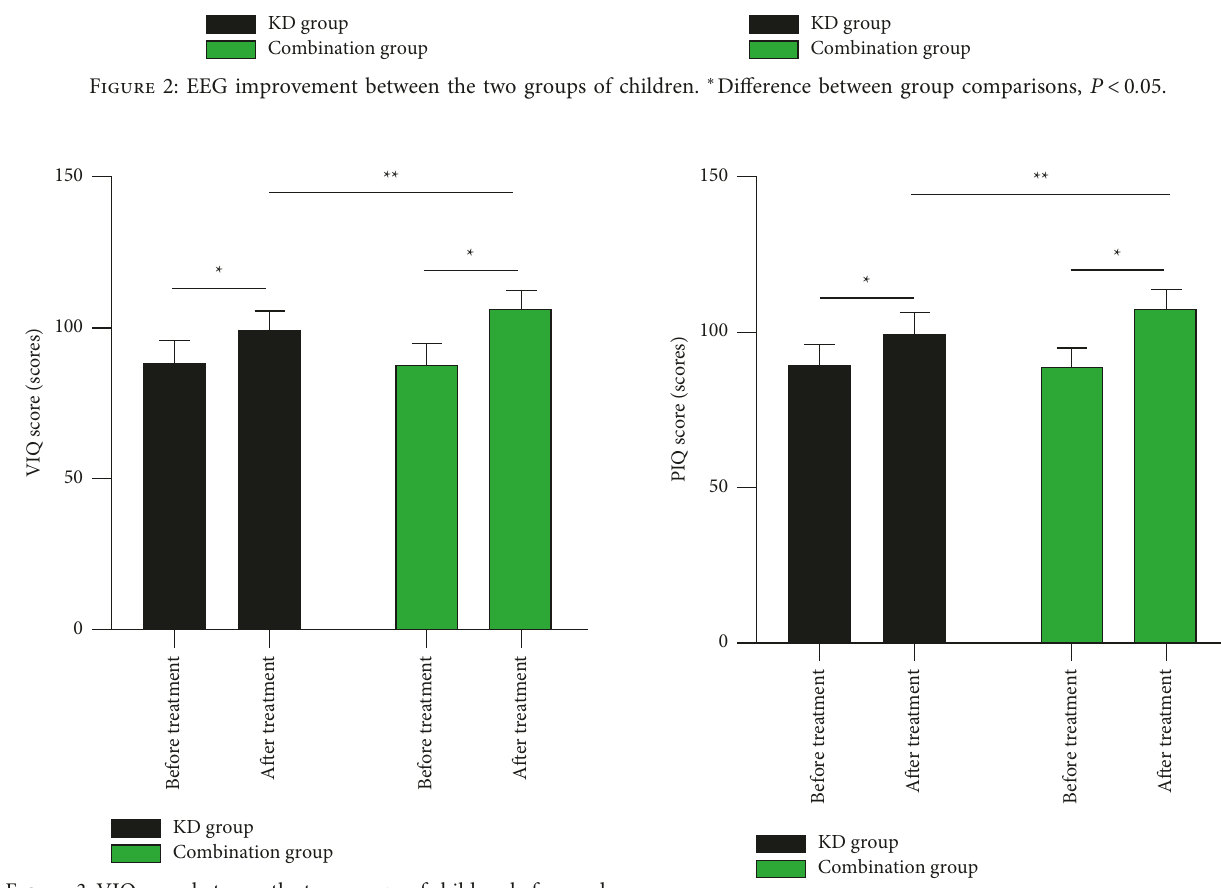
Figure 4: PIQ score between the two groups of children before and after treatment. ∗ Comparison between the same group before and after treatment, P < 0 . 05; ∗∗ comparison between groups after treatment, P < 0 . 05.